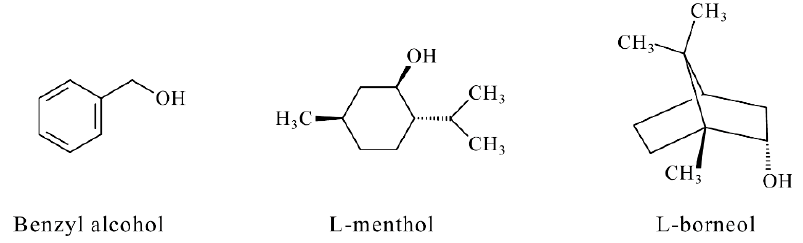
Figure 1. Structure of benzyl alcohol, L-menthol and L-borneol.